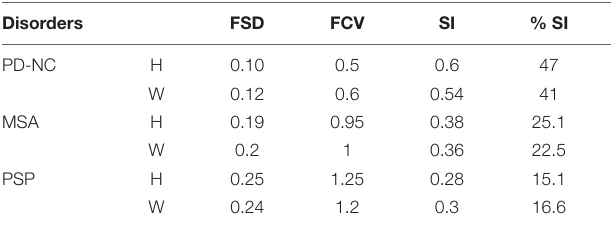
TABLE 5 | Scatter Index (SI) Values (using Energy) for Parkinsonian disorders obtained from AI: using Hofer (H) and Witelson (W)